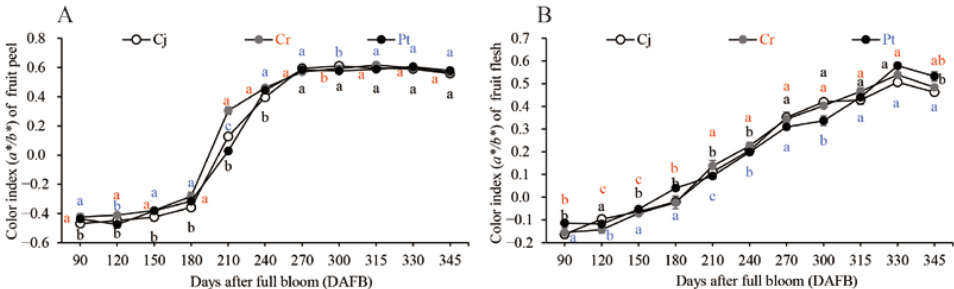
Figure 3. Dynamic changes in the color index of the fruit epicarp ( A ) and flesh ( B ) of the blood orange grafted onto different rootstocks during fruit development and ripening. The color index is expressed in a */ b * Hunter ratio.